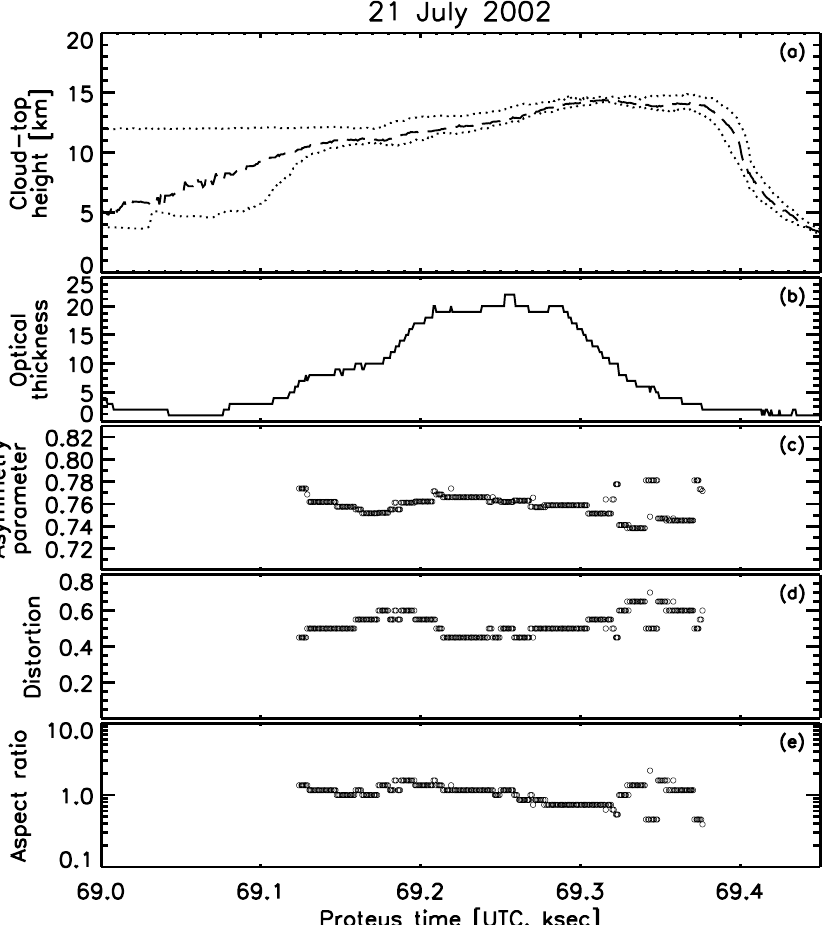
Fig. 10. RSP retrieval as a function of time for 21 July. (a) Cloud-top height with minimum and maximum retrieved heights in dotted lines; (b) cloud optical thickness; (c) asymmetry parameter, (d) distortion parameter; and (e) aspect